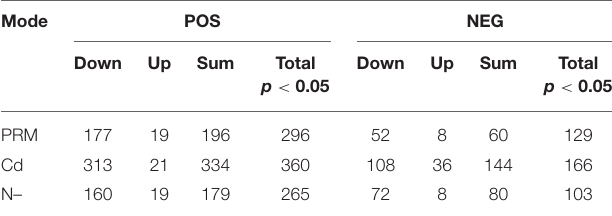
TABLE 2 | Summary of metabolomics: differential metabolites under different stresses (PRM, paromomycin; Cd, CdCl2; N–, nitrogen deprivation) and under negative (POS) and positive (NEG) ion